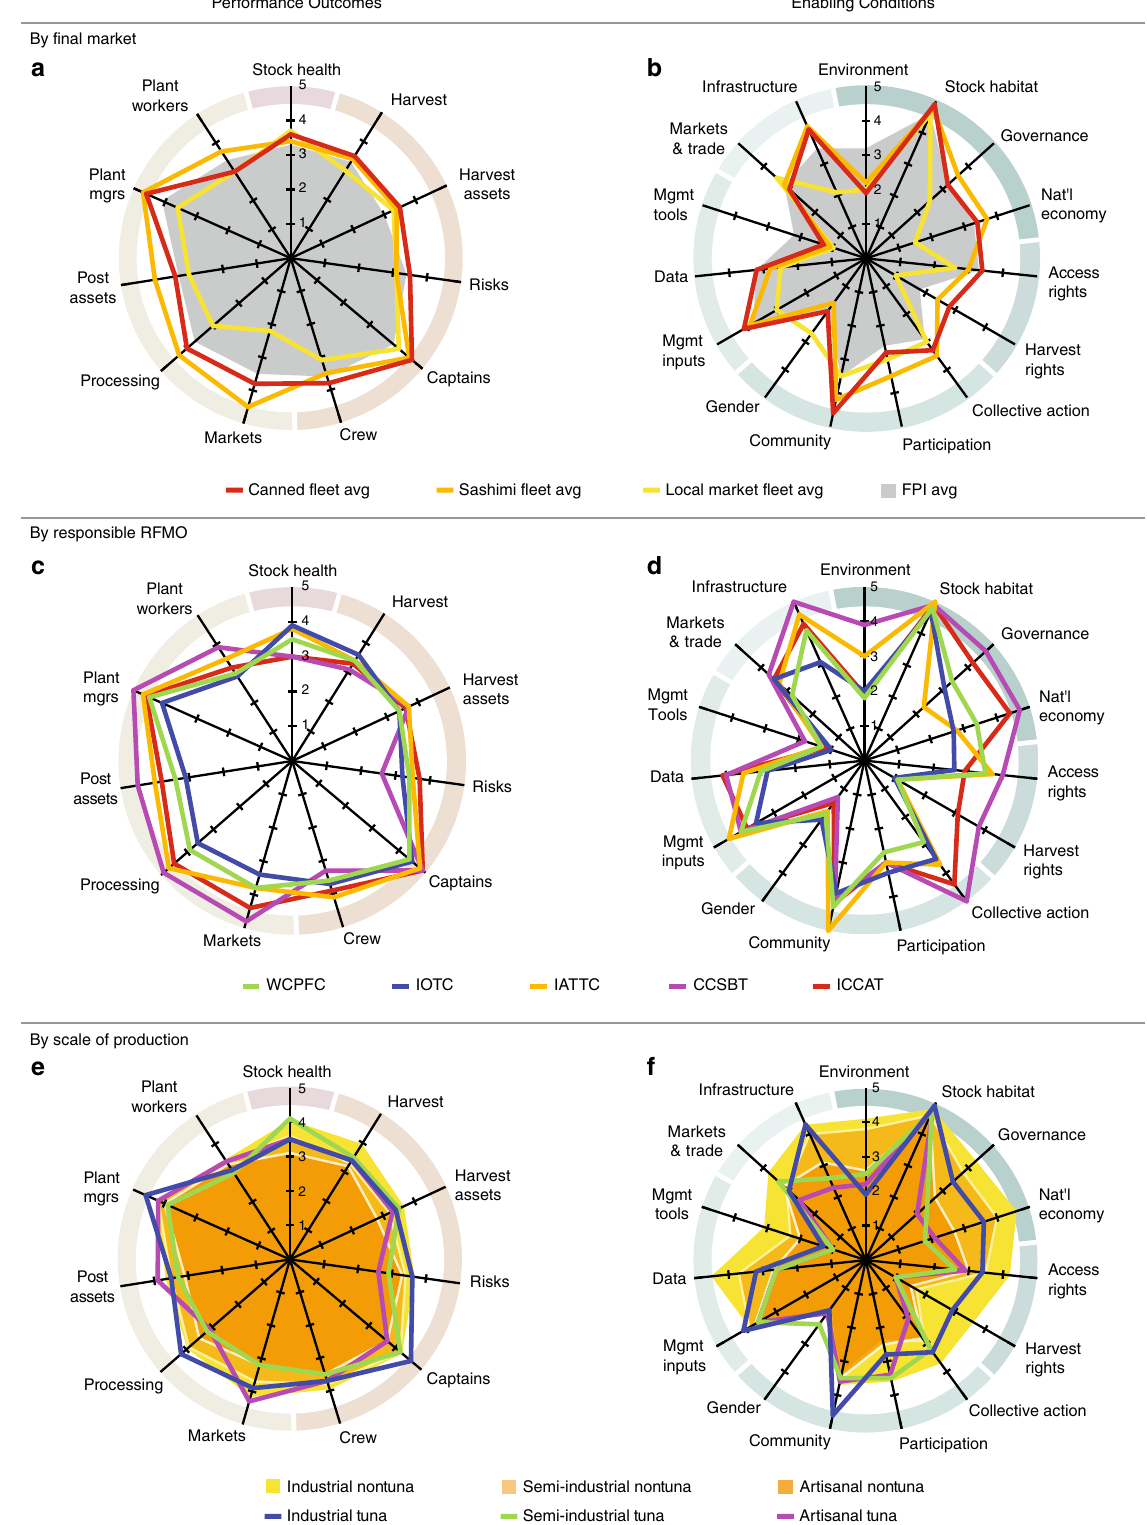
Fig. 1 Volume-weighted averages of tuna fi shery FPI scores. Fisheries are grouped by by fi nal product market (Output panel a ; Input panel b ) with a comparison to all non-tuna FPI case studies (grey solid fi eld), governing RFMO (outcomes panel c ; enabling conditions panel d ), and industrial scale of production (outcomes panel e ; enabling conditions panel f ) with a comparison to non-tuna FPI case studies (yellow solid fi elds). Radial axes re fl ect volume- weighted average of the dimension score, with higher scores interpreted as better performance only in the outcome panel. On the outcome panels, a pink outer ring indicates the dimension of the Ecology indicator; orange, the dimensions of the harvest sector indicator; and beige, the dimensions of the post- harvest sector indicator. On the enabling condition panels, shades of green indicate dimensions comprising different components of the enabling